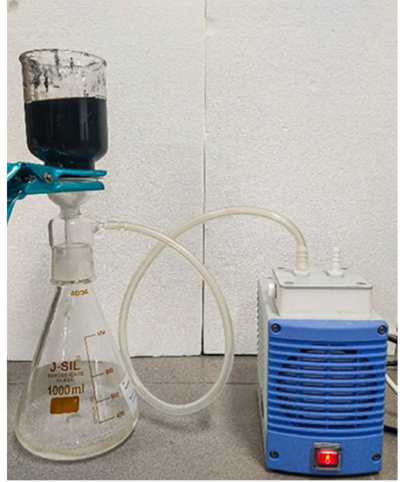
Figure 10. The process of vacuum filtering of activated carbon-treated glycerol.